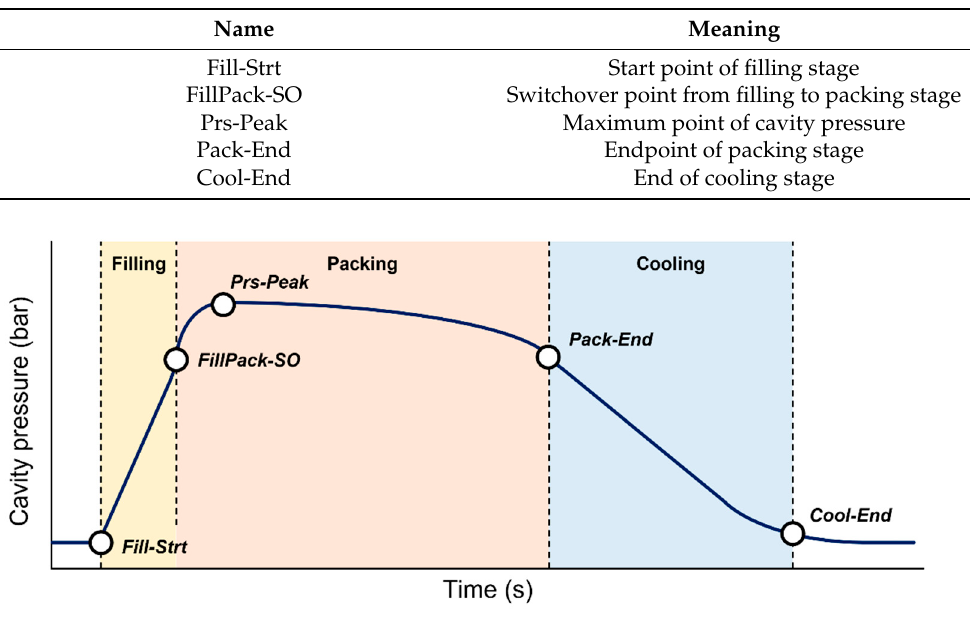
Figure 5. Process state points (PSPs) of typical cavity pressure profile and effective process stages in the cavity.